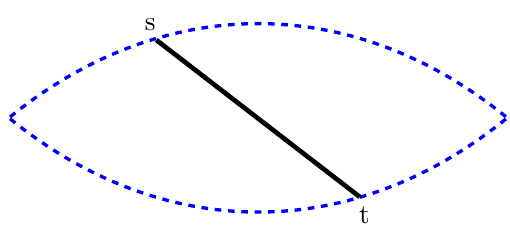
Figure 16 . One loop diagram, contributing to the ground state anomalous dimension.